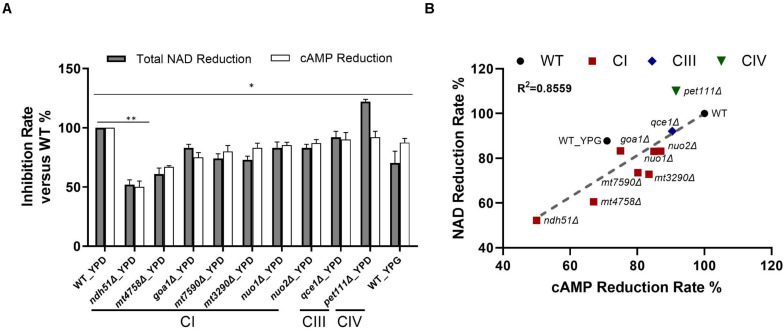
Direct correlation of total NAD with cAMP reduction levels. (A) The greatest NAD in the CI mutant ndh51Δ grown in YPD corresponds to a ∼50% cAMP reduction. The moderate NAD reductions shown in the CI mutant mt4758Δ and in the CI regulator mutant goa1Δ correspond to 32 and 25% cAMP reductions, respectively. A cAMP reduction of less than 10% in the CIII and CIV mutants reflects their respective abilities to maintain normal or even higher-than-normal NAD concentrations. (B) A strong direct (and linear) relationship between total NAD and cAMP reduction levels among CI, CIII, and CIV mutants (R2 = 0.8559). These results suggest a close relationship for ETC proteins with NAD metabolism and cAMP/PKA state during NADH oxidation in C. albicans mitochondria. Data are taken in triplicate, and comparisons are done between WT and each mutant in panels (A,B) under the same culture conditions. p values <0.001 are denoted as “**” for <0.01 and “*” for < 0.05.